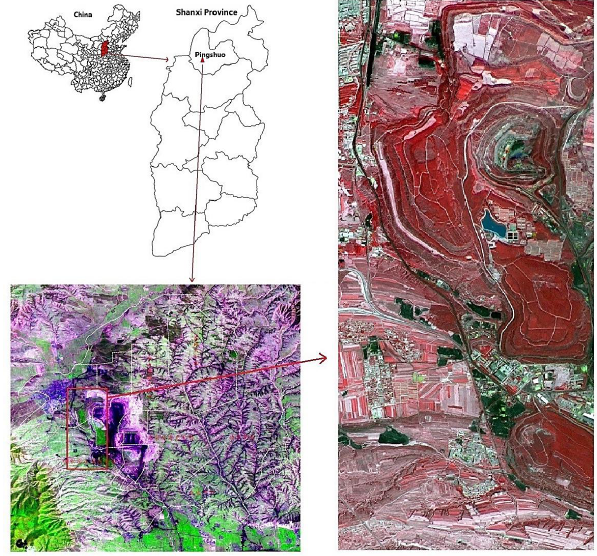
Figure 1. Study area: Pingshuo open-pit